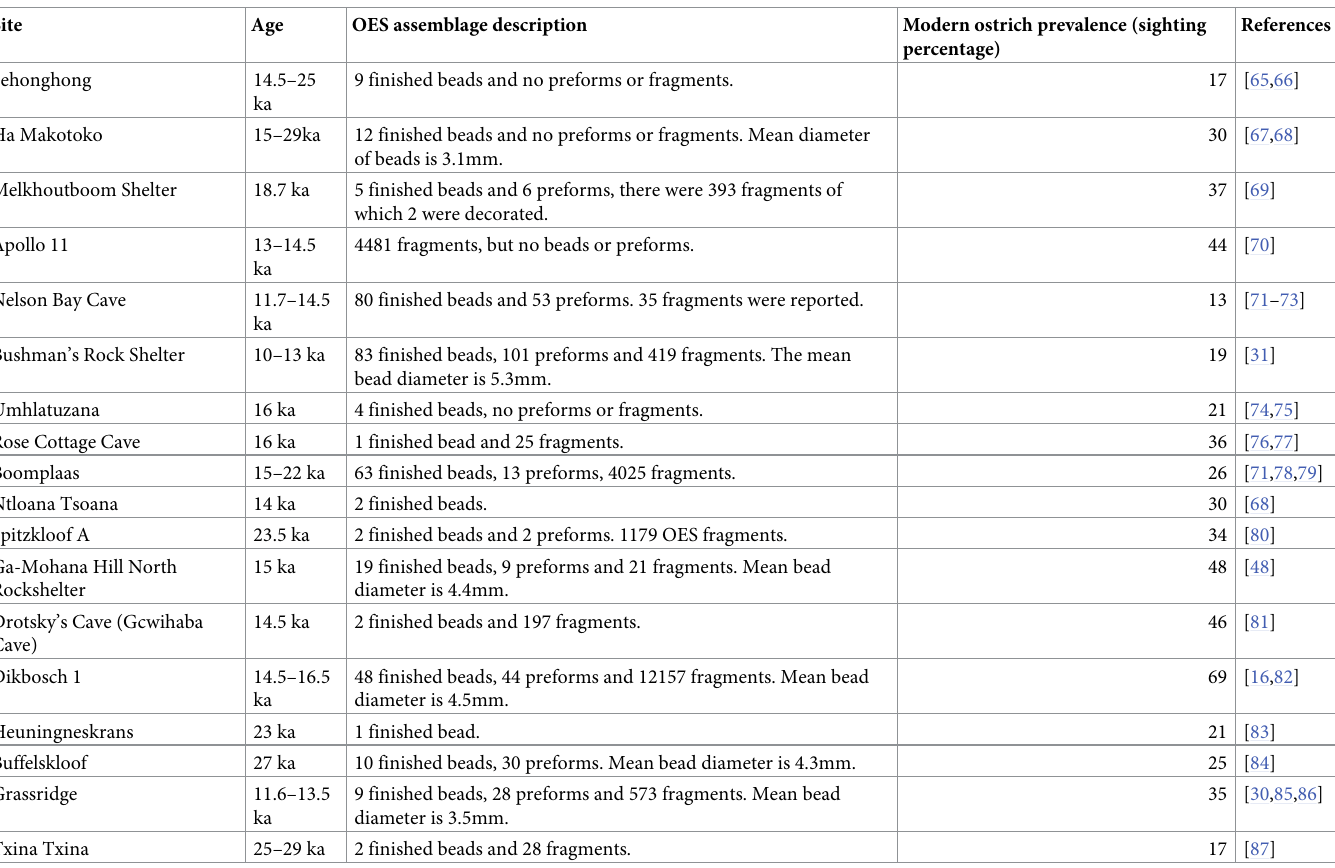
Table 3. MIS 2 dated sites in southern Africa with OES assemblages. Modern ostrich prevalence has been calculated from SABAP 2 [60].Ostrich sighting data was inter- polated across southern Africa and the values included here are the mean of a 5km radius around each site location. More detailed information on the sites and OES assem- blages are available in S1